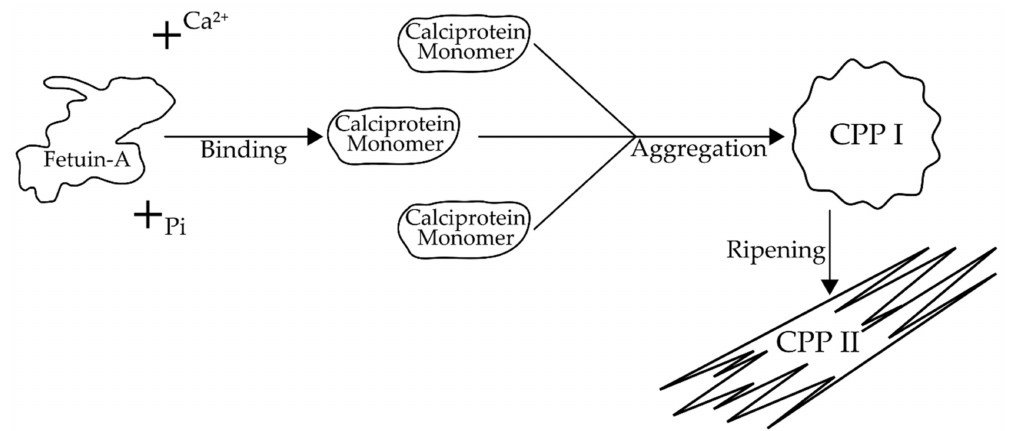
Figure 2. Fetuin-A transformation into CPP II. Abbreviations: Pi, phosphate; CPP I, primary calciprotein particle; CPP II, secondary calciprotein